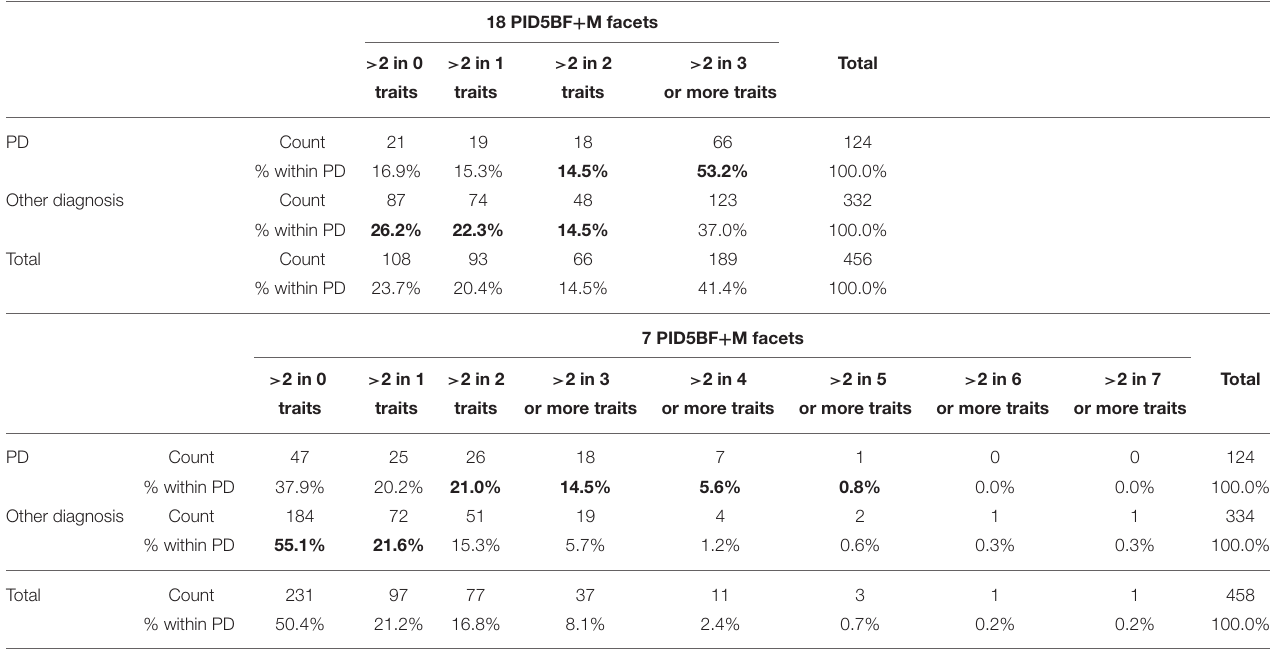
TABLE 4 | Number and percentage of individuals from the personality disorder (PD) and non-personality disorder (non-PD) samples with scores above 2 in the 18 PID5BF M facets and in the seven PID5BF M facets that differentiate the + +